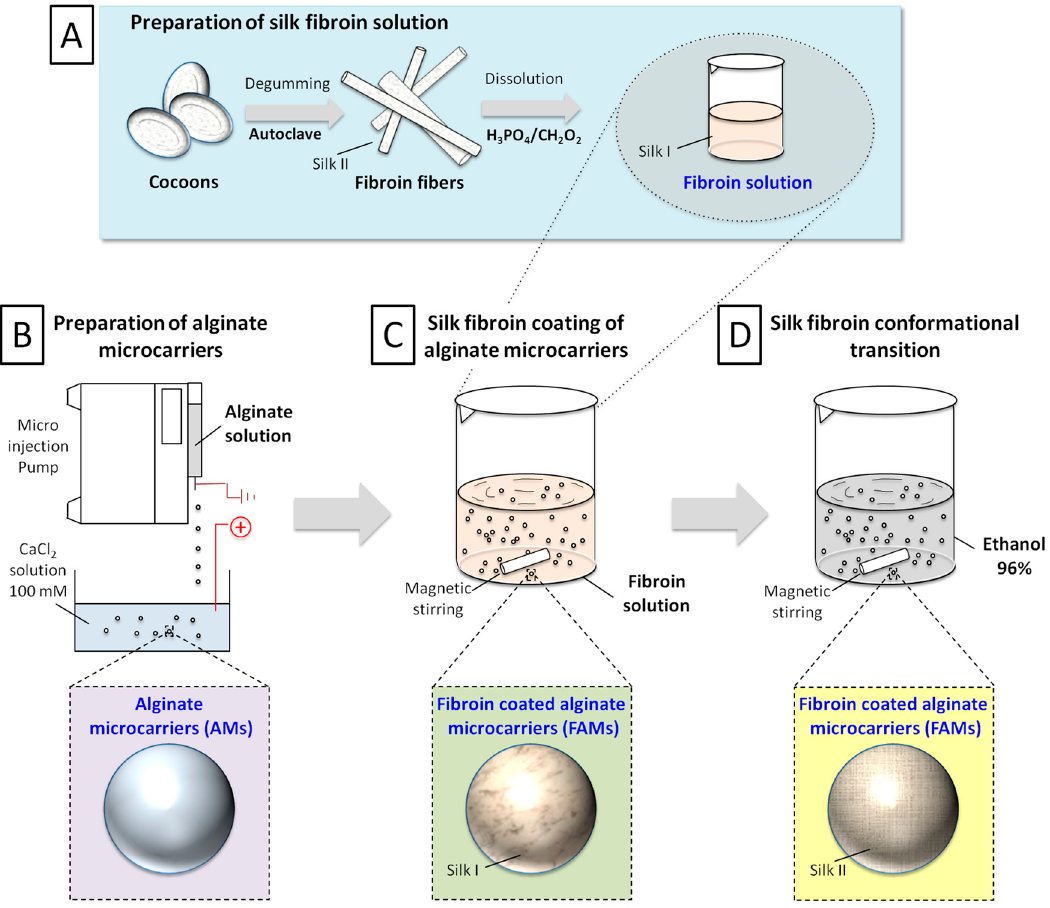
Figure 1. Schematic representation of production process: preparation of silk fibroin solution ( A ); Preparation of alginate cores ( B ); Coating of alginate cores with silk fibroin solution obtaining fibroin/alginate microcarriers ( C ); Silk fibroin conformational transition, obtaining stable composite devices ( D ).